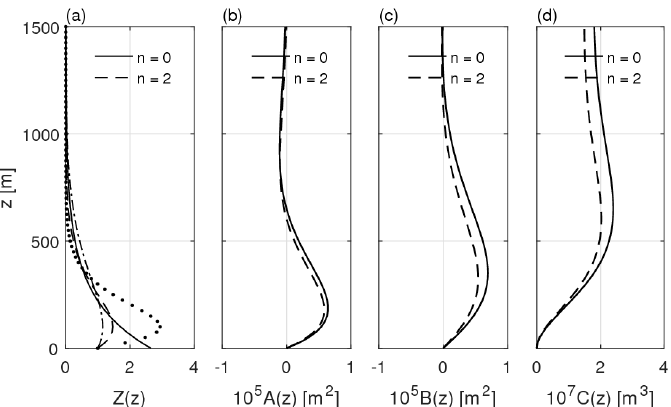
Figure 1. Vertical distributions of the non-dimensional temperature Z ( z ) ( a ), A ( z ) ( b ), B ( z ) ( c ), and C ( z ) ( d ). The solid curves (noted by n = 0) denote the non-temperature inversion (NTI) case, while the dashed lines (noted by n = 2) represent the surface temperature inversion (STI) case. The inversion lid is set to a height of 100 m from the urban surface. The specified parameter values are appointed n = 0, h 2 = 227.5 m for the NTI case (solid lines) and n = 2, h 1 = 100 m, h 2 = 100 m for the STI case (dashed lines) to ensure that the most significant difference between the two profiles occurs in the temperature inversion layer. The dotted and dash-dotted lines in ( a ) are another two STI profiles with parameters of n = 2, h 1 = 40 m, h 2 = 70 m and n = 2, h 1 = 200 m, h 2 = 150 m. The inversion thicknesses of the two profiles are 100 m, which is the same as that of the STI profile denoted by dashed lines.